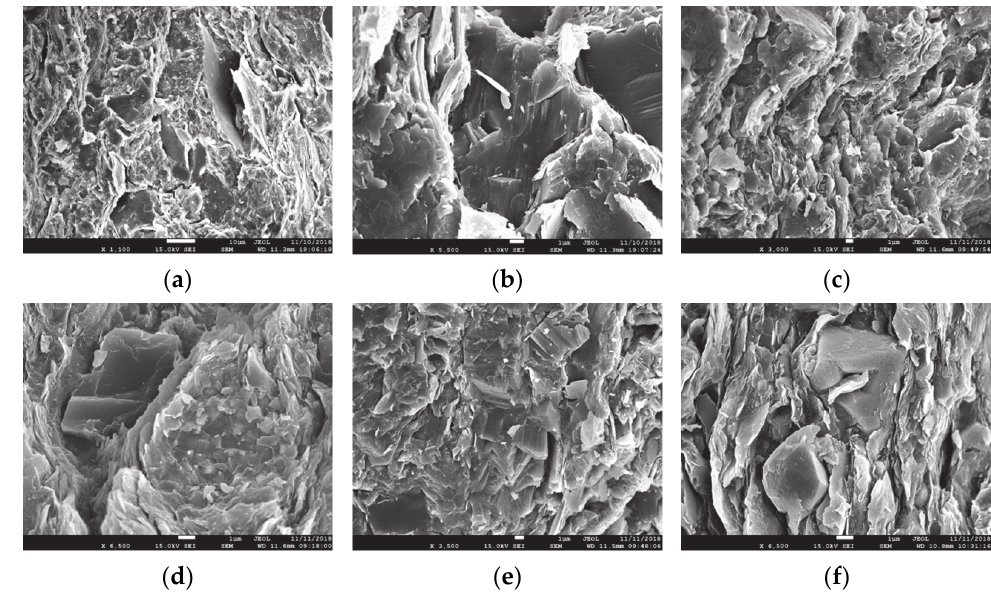
Figure 3. Scans of different minerals in shale oil formations. ( a ) Quartz grains; ( b ) Feldspar grains; ( c ) Clay minerals; ( d ) Calcite; ( e ) Carbonate particles; ( f ) Pyrite particles.